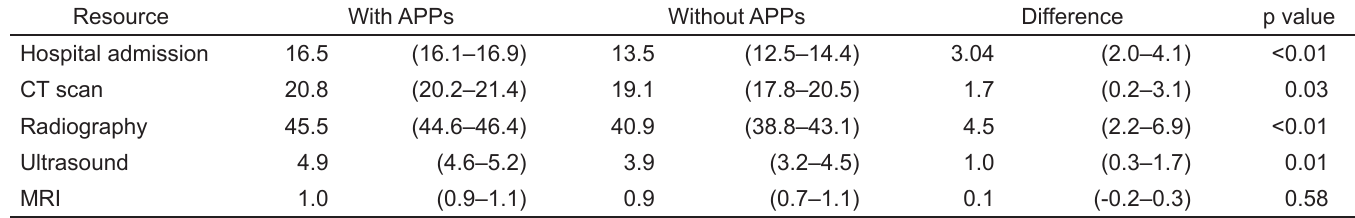
1 Data are means and 95% confidence intervals adjusted for high acuity, volume, and attending